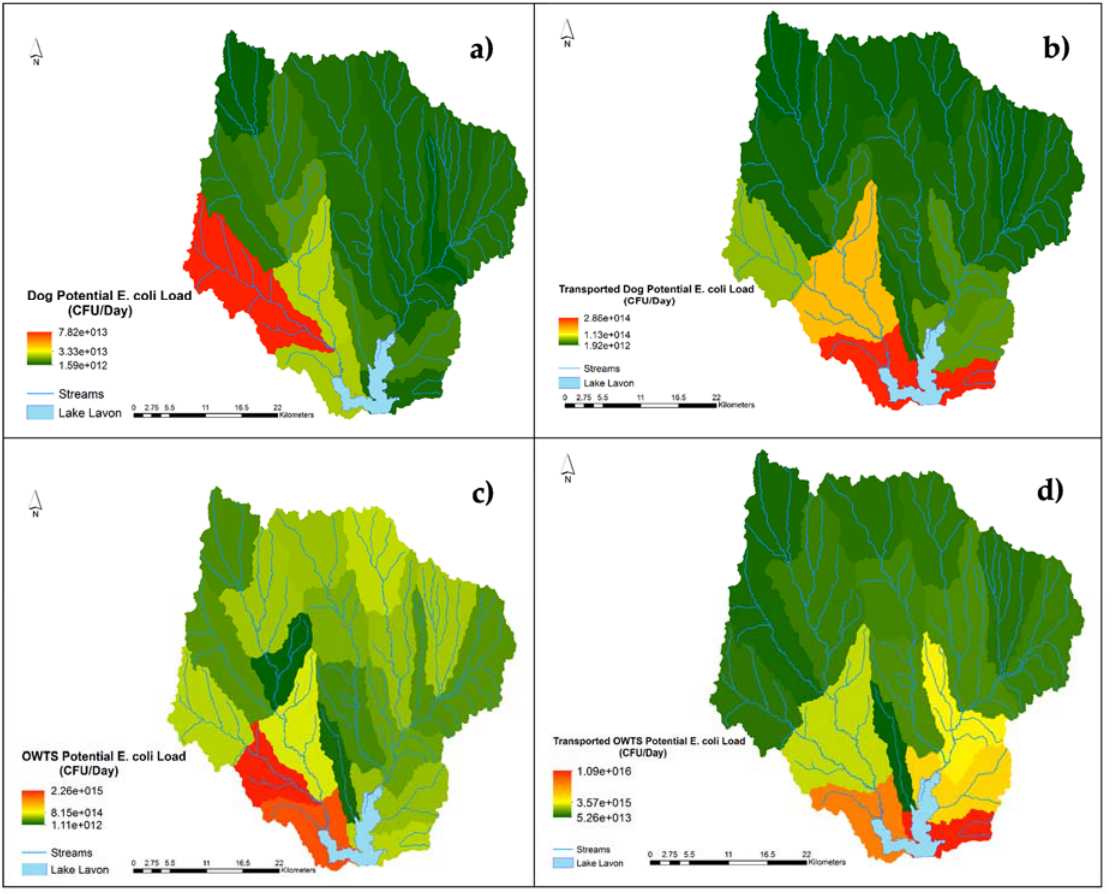
Figure 7. Potential E. coli load subwatershed summation from ( a ) dogs and ( c ) OWTS in the Lavon Lake watershed. Subwatershed maximum transported potential E. coli load from ( b ) dogs and ( d ) OWTS due to a 2 ‐ year, 24 ‐ h storm event in the Lavon Lake watershed.